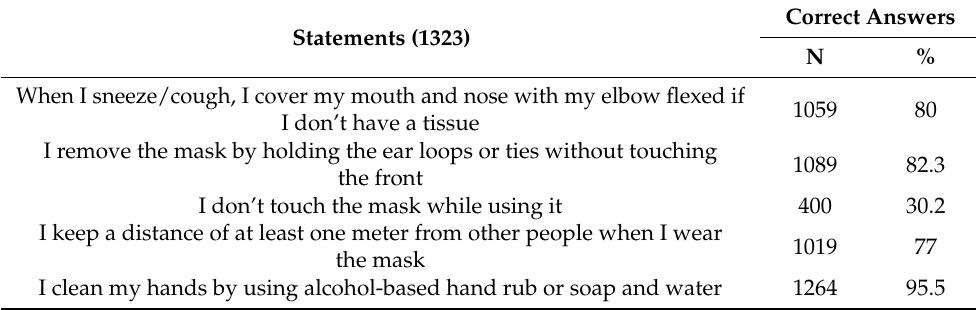
Table 3. Adherence to